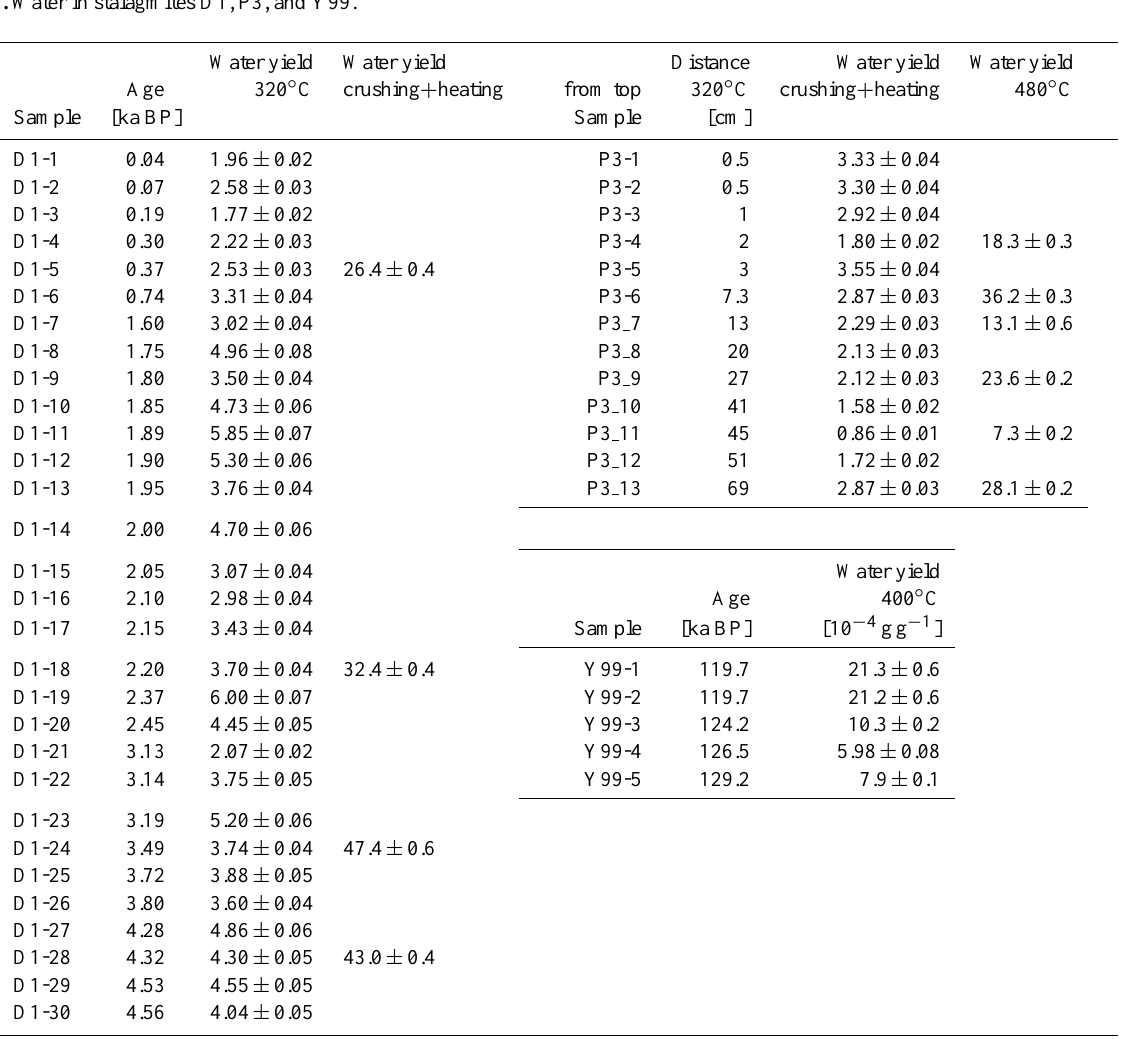
Table 2. Water in stalagmites D1, P3, and